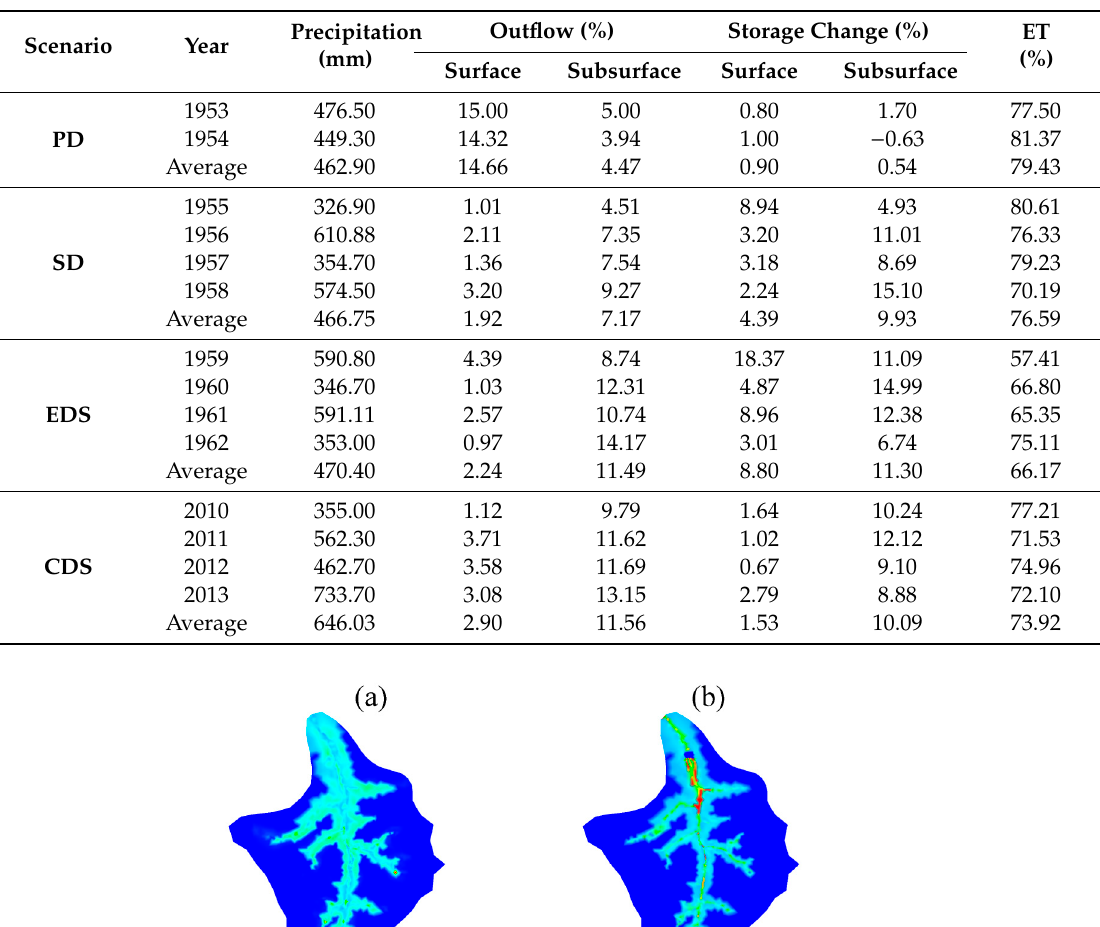
Table 7. Water redistribution in long-term simulations of GDG catchment.